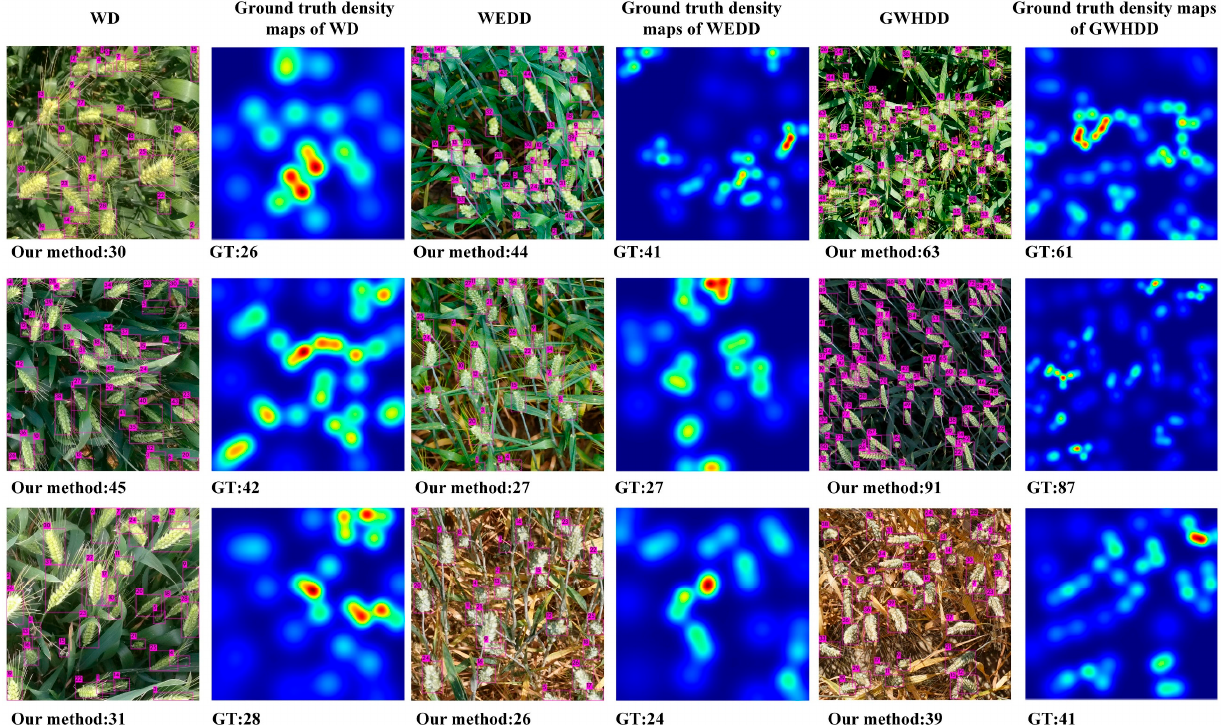
Figure 8. The comparison between the true value and the estimated value of a single image of different data sets.